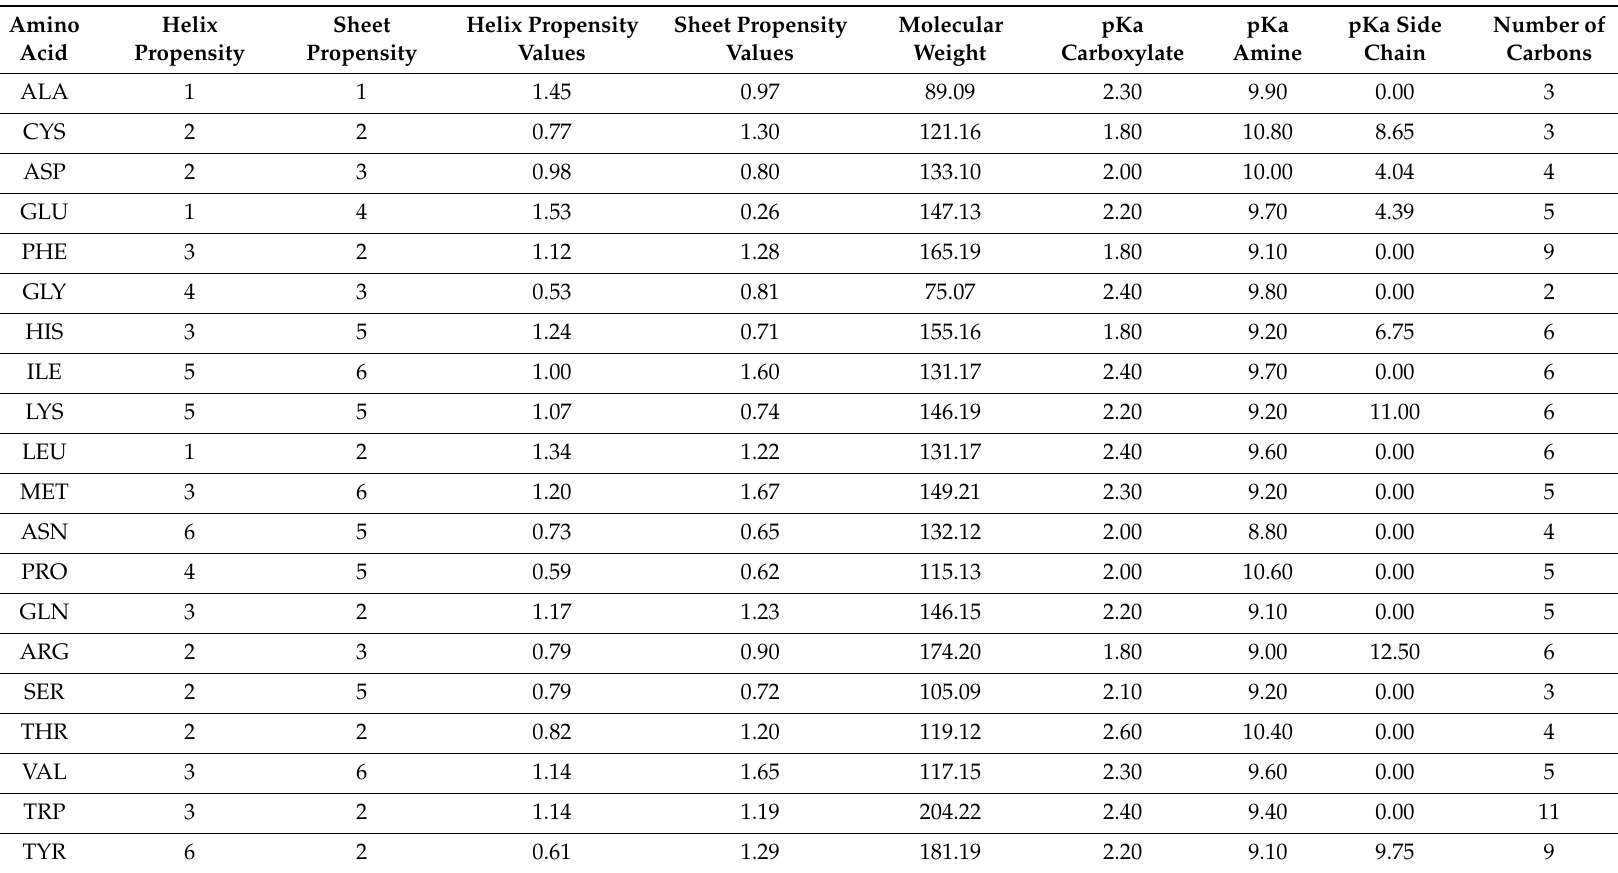
Table A4. Literature-based amino acid features, such as secondary structure propensity, pKa associated values, number of atoms of each type and standard area and mass associated values, attained from BioMagResBank